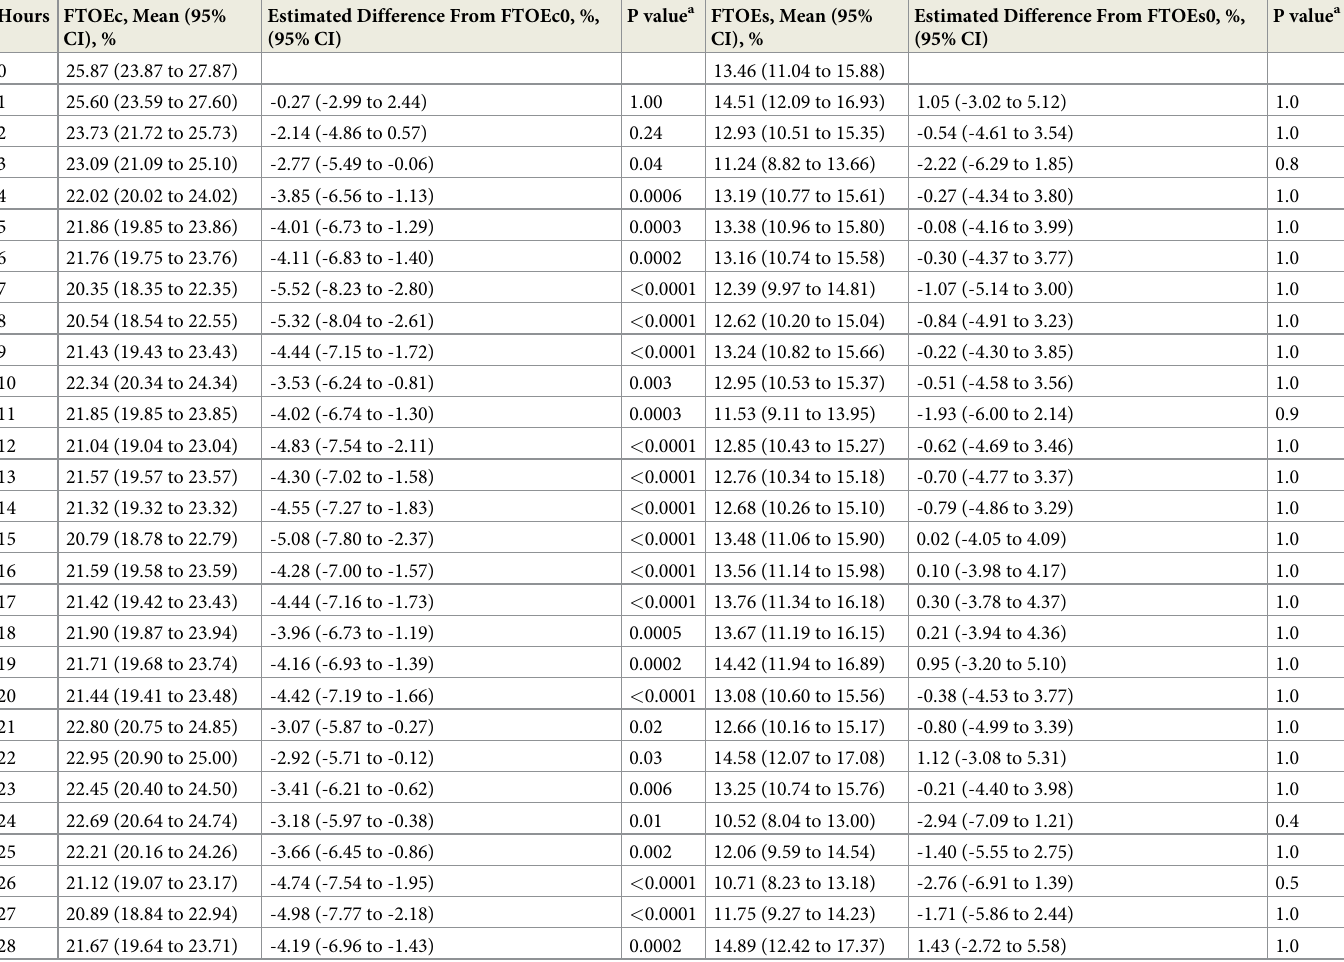
Table 2. Exploratory analysis of cerebral and splanchnic fractional tissue oxygen extraction in association with packed red blood cell transfusion—mixed model for repeated measures (n = 29). Hours FTOEc, Mean (95% CI), %